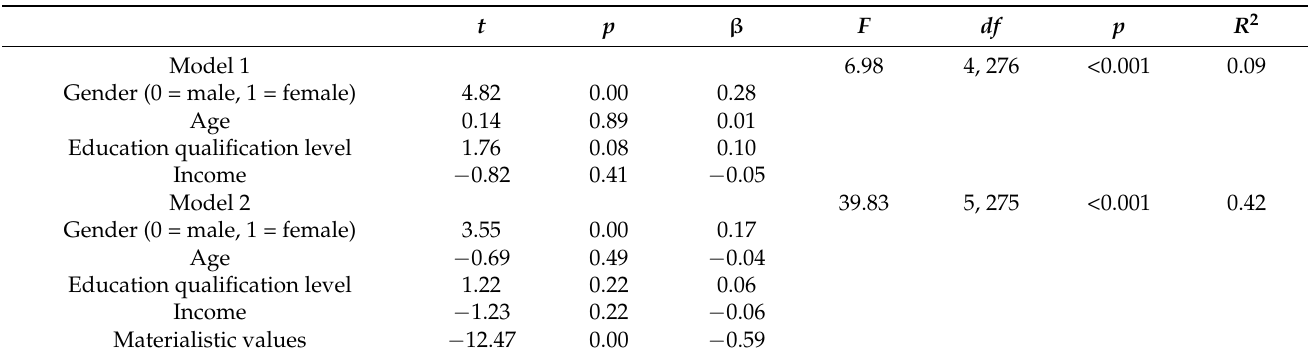
Table 1. Linear Regression Analysis examining the influence of the materialistic values on suffi- ciency attitudes.